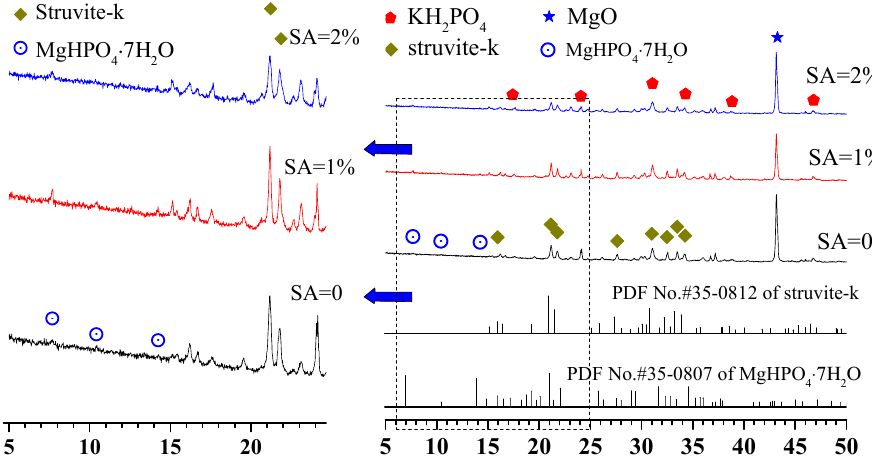
Figure 7. XRD diffraction patterns of MKPC at a w/c ratio of 0.2 after 1 day of curing. Figure 8 presents the phase assemblage patterns of MKPCs at a w/c ratio of 0.2 and cured for 28 days. The hydration products after 28 days were the same as the MKPCs cured for 1 day. However, the quantities of MgO from the MKPCs with 1% sodium algi- nate at 28 days were found to be lower than those with 2% sodium alginate and the refer- ence ones. Furthermore, a reverse rule was noticed for the quantities of struvite-k. This suggested that addition of sodium alginate at a content of no more than 1% could contrib- ute to the reaction of the MKPC system, but a reverse effect would be found with more than 1% sodium alginate.